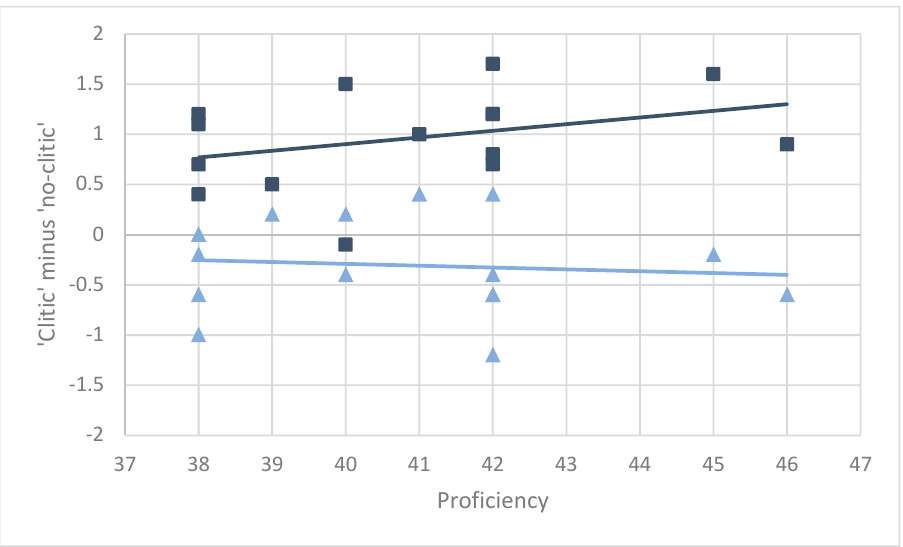
Figure 3. Difference between utterances containing a clitic pronoun minus those which do not in [+a] (dark blue circles) and [ − a] (light blue squares) discourse contexts, on the AJT, by proficiency score.